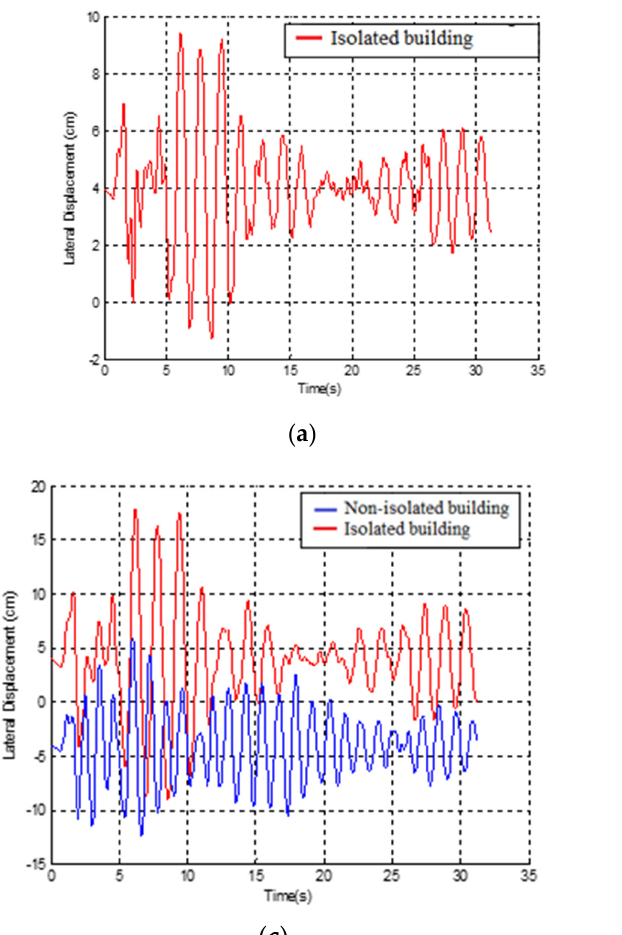
Figure 6. Schematic diagram of two three ‐ story isolated models and the locations of rubber bump ‐ ers.